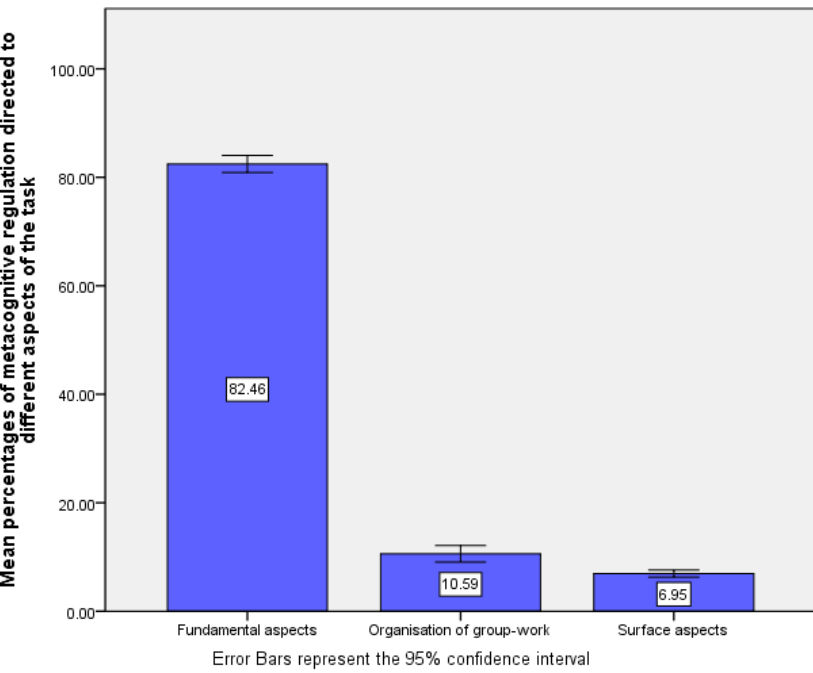
Figure 4 . Bar graph of mean percentages of metacognitive regulation behaviours per direction of